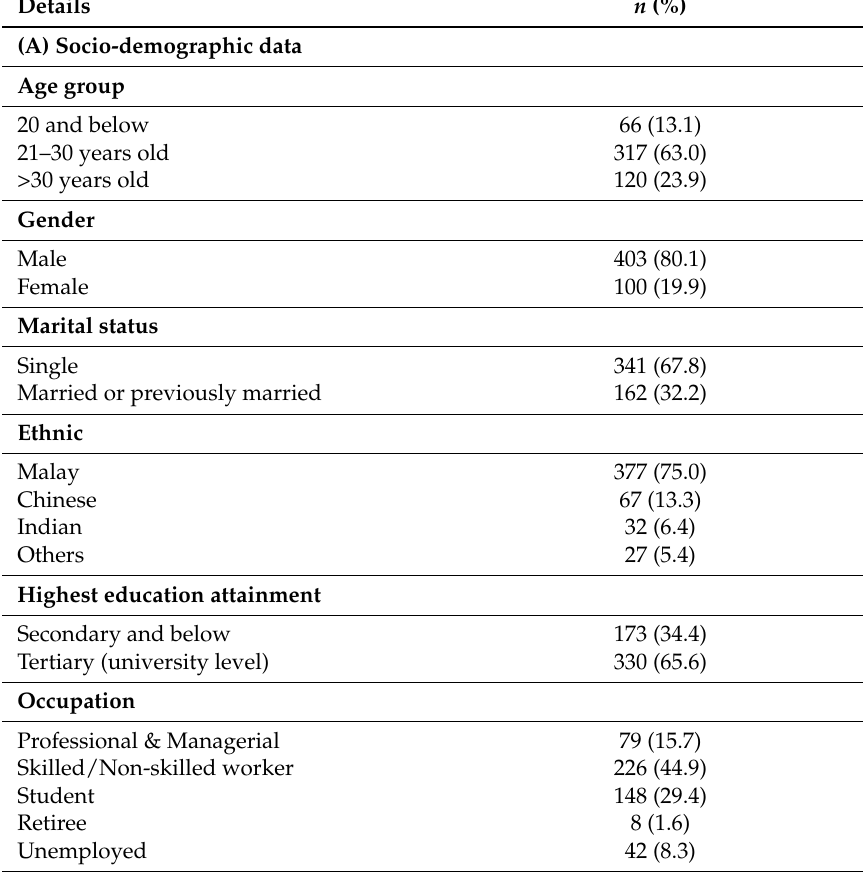
Table 1. Distribution of socio-demographic characteristics and shisha smoking practices ( N =